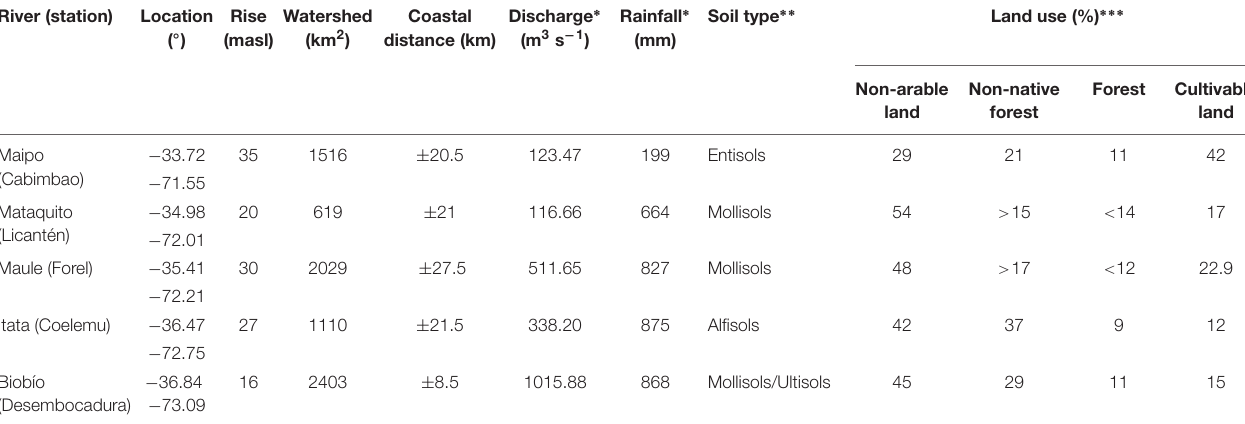
TABLE 1 | Regional characterization of rivers in Central Chile, from 33 ◦ to 37 ◦ S. River